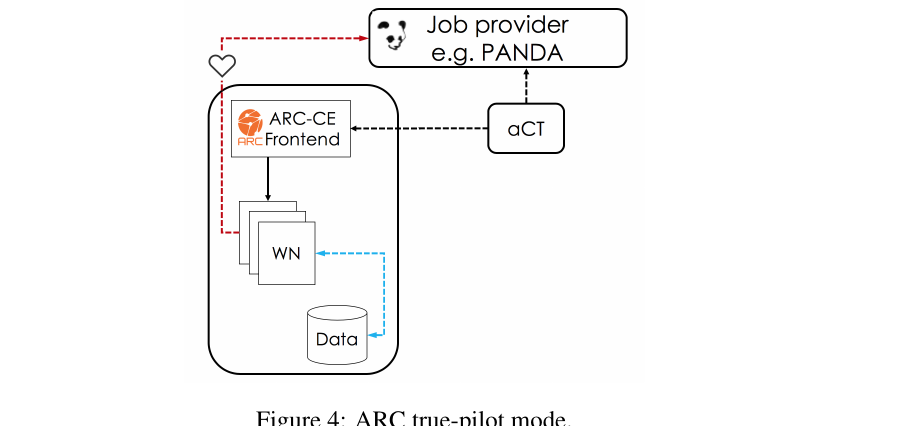
Figure 4: ARC true-pilot mode.